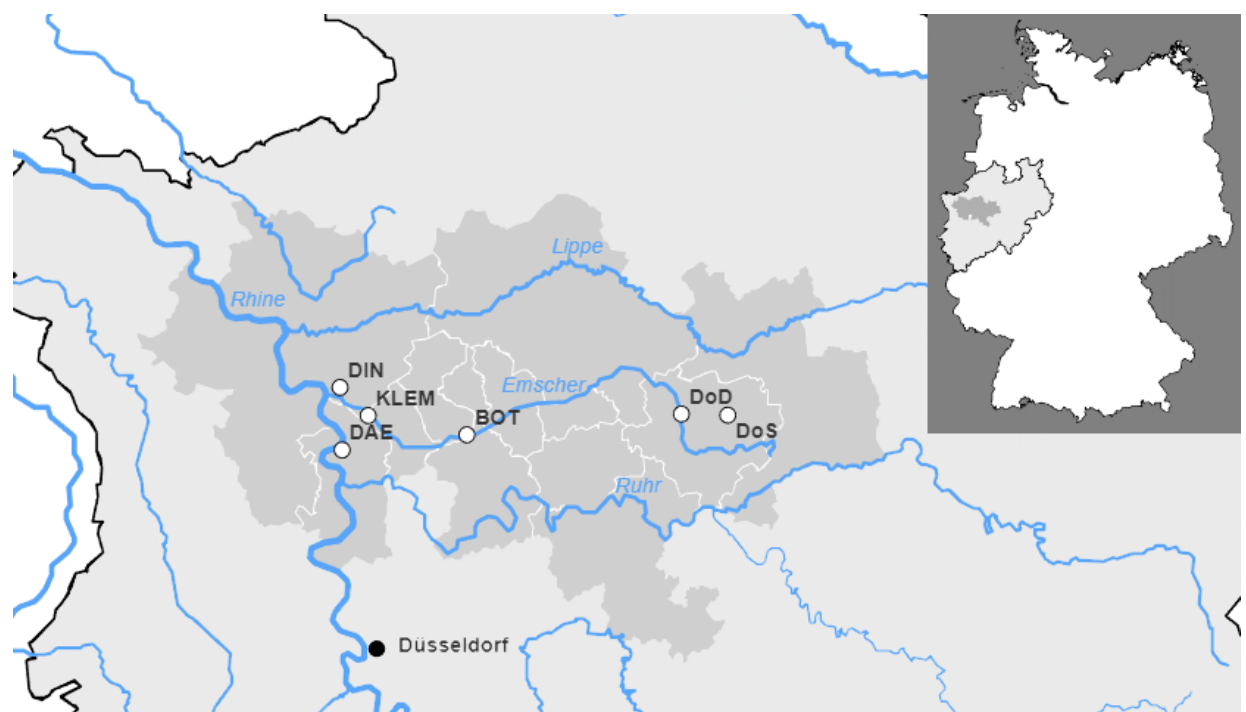
Figure 1. The wastewater treatment plants monitored as part of this study. Regional representation of the municipal districts (dark gray) connected to the respective wastewater treatment plants in the German state of North Rhine-Westphalia. The sewage treatment plants are shown as white circles with black borders. Rivers are shown in blue, federal state borders in black. Cities are shown as black circles for further orientation. A general map of Germany to illustrate the overall view, indicating the colors, is given at the top right. Table 1. Key properties of the six wastewater treatment plants sampled in this study. Data were obtained from ELWAS-WEB, an electronic water management system for administration in NRW (accessed 29 June 2022).